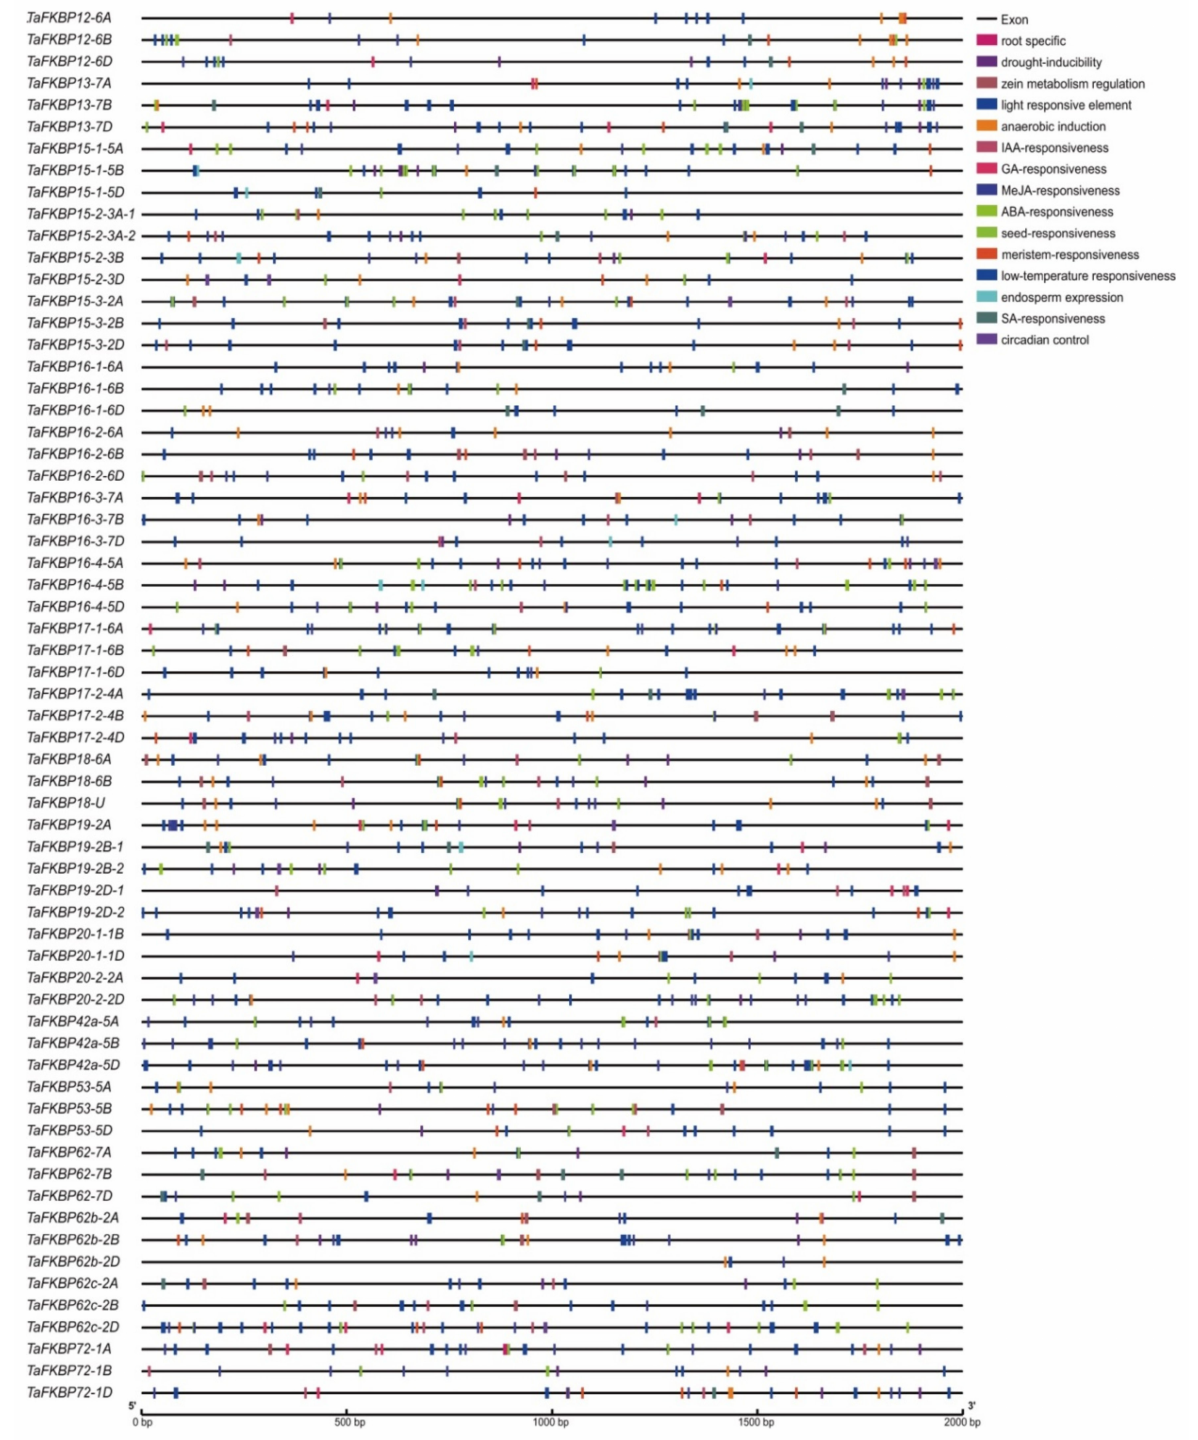
Figure 5. Predicted cis-acting elements in the promoters of TaFKBP genes. The promoter sequences ( − 2000 bp) of 64 TaFKBP genes analysis by